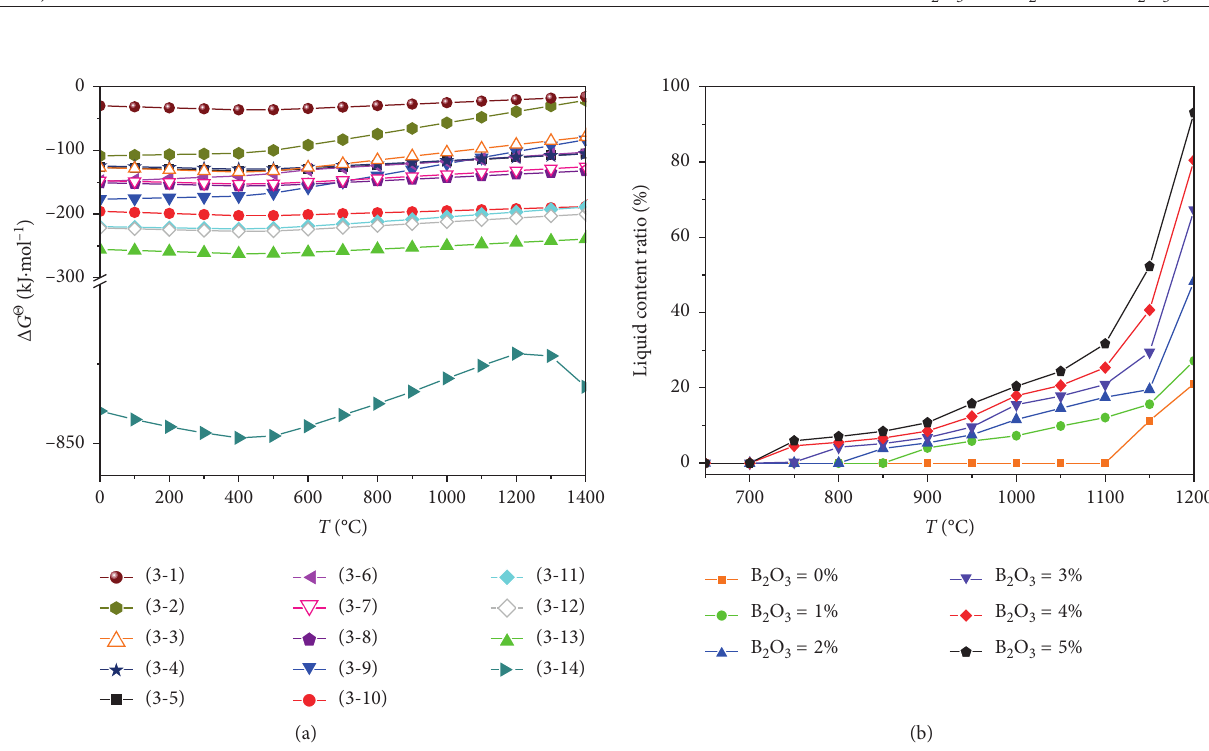
Figure 8: Gibbs free energy of B 2 O 3 and oxides and liquid content of the pellets at different B 2 O 3 addition.